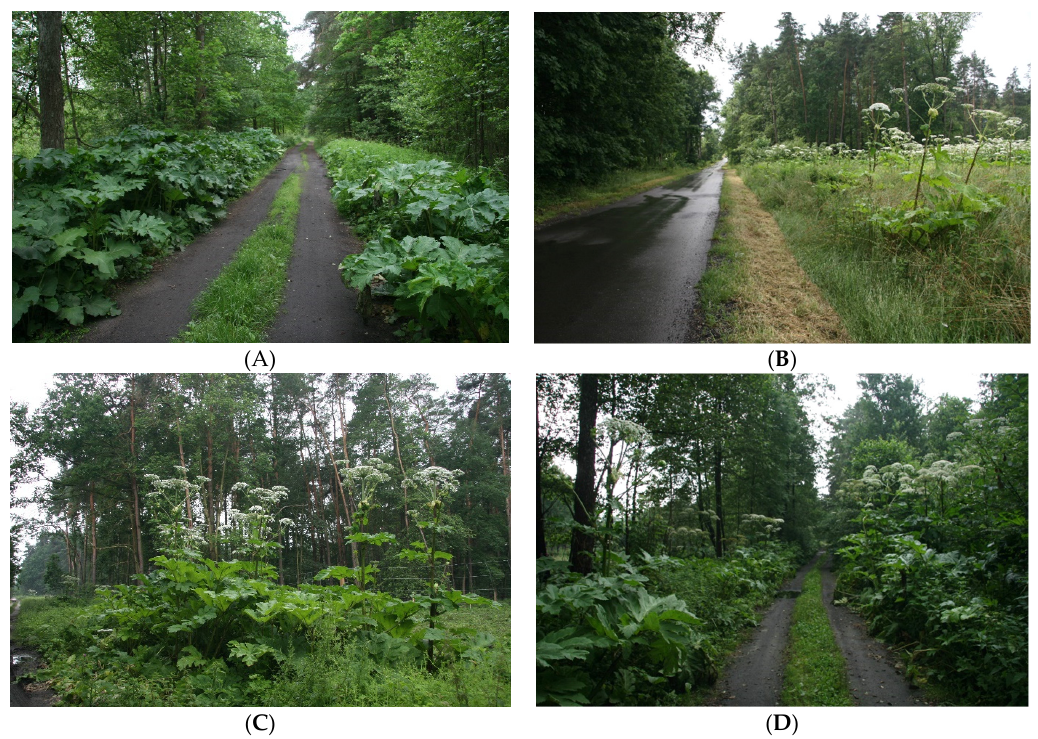
Figure 2. An example of forest with the former Sosnowsky’s hogweed crop in its glade photo ( B ), where the invading species spreads along roads ( A , B , D ), photo ( A ) is from early June, photos ( B – D ) are from July (author of photographs: E. Grz ę dzicka).